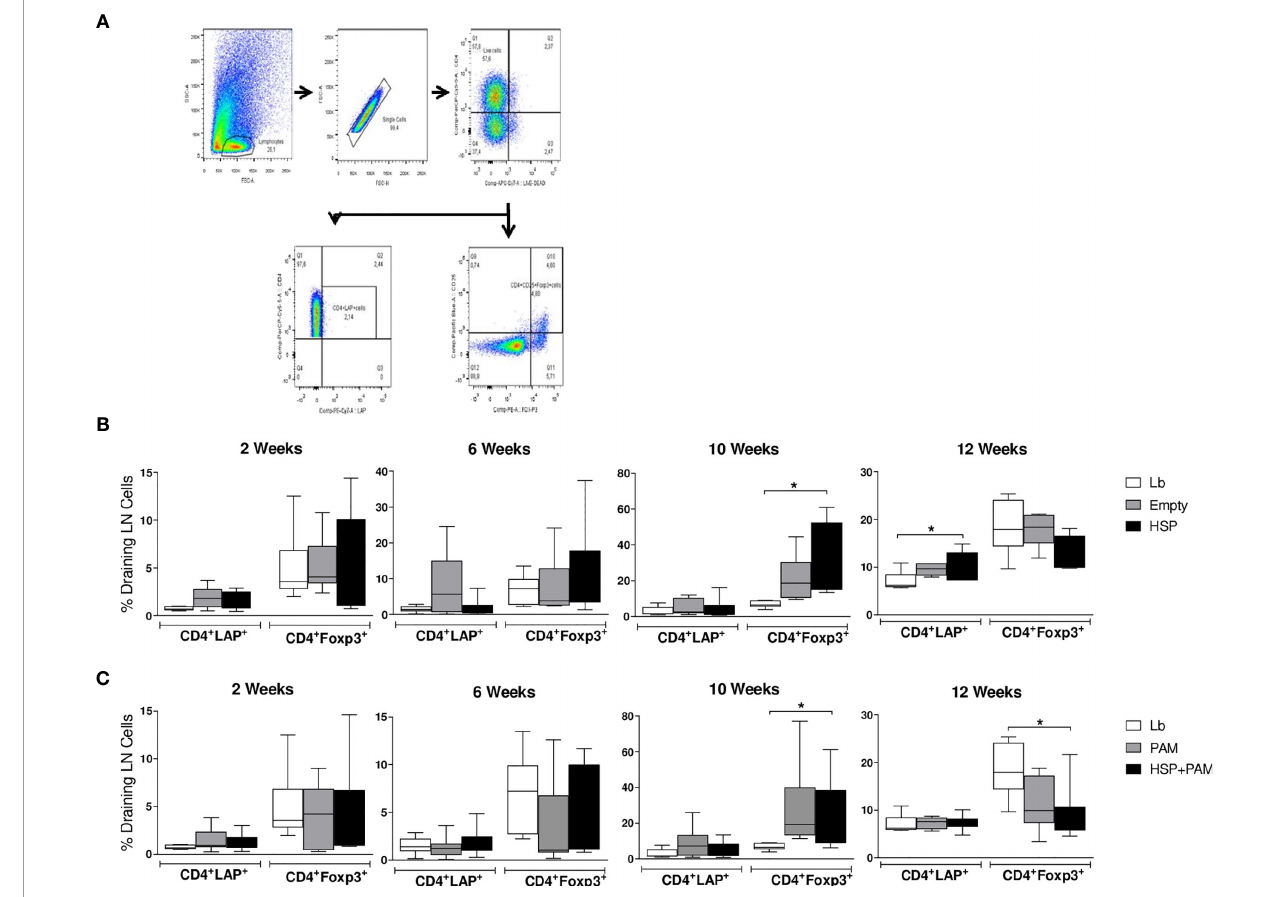
FIGURE 4 | CD4 + LAP + and CD4 + FoxP3 + regulatory T cell expression following re-stimulation with L. braziliensis. Mice were treated with water (Lb and PAM), GM17 medium with empty vector-bearing L. lactis (Empty) or XM17 medium containing Hsp65-producing L. lactis (HSP and HSP+PAM) for 4 consecutive days, then inoculated with L. braziliensis metacyclic promastigotes in the ear 10 days later. Two days prior to infection, the HSP+PAM and PAM groups received an intraperitoneal administration of PAM3CSK4. After euthanizing animals at 2, 6, 10 and 12 weeks post-infection, draining lymph nodes were collected, cell suspensions were cultured with live L. braziliensis for 18h and stained using surface antibodies (anti-CD4 and anti-LAP) and intracellular molecules (anti-Foxp3). (A) Representative scatter plots of gating strategy. (B) Relative frequencies of CD4 + LAP + and CD4 + Foxp3 + regulatory T cells in the draining lymph nodes of Lb, Empty and HSP groups. (C) Relative frequencies of CD4 + LAP + and CD4 + Foxp3 + regulatory T cells in the draining lymph nodes of Lb, PAM and HSP+PAM groups. All frequencies of regulatory T cells are represented as medians and interquartile range. Data are representative of four independent experiments involving 10 animals per group. For nonparametric data, Kruskal-Wallis with Dunn ’ s post-test was used; (*) indicates P <